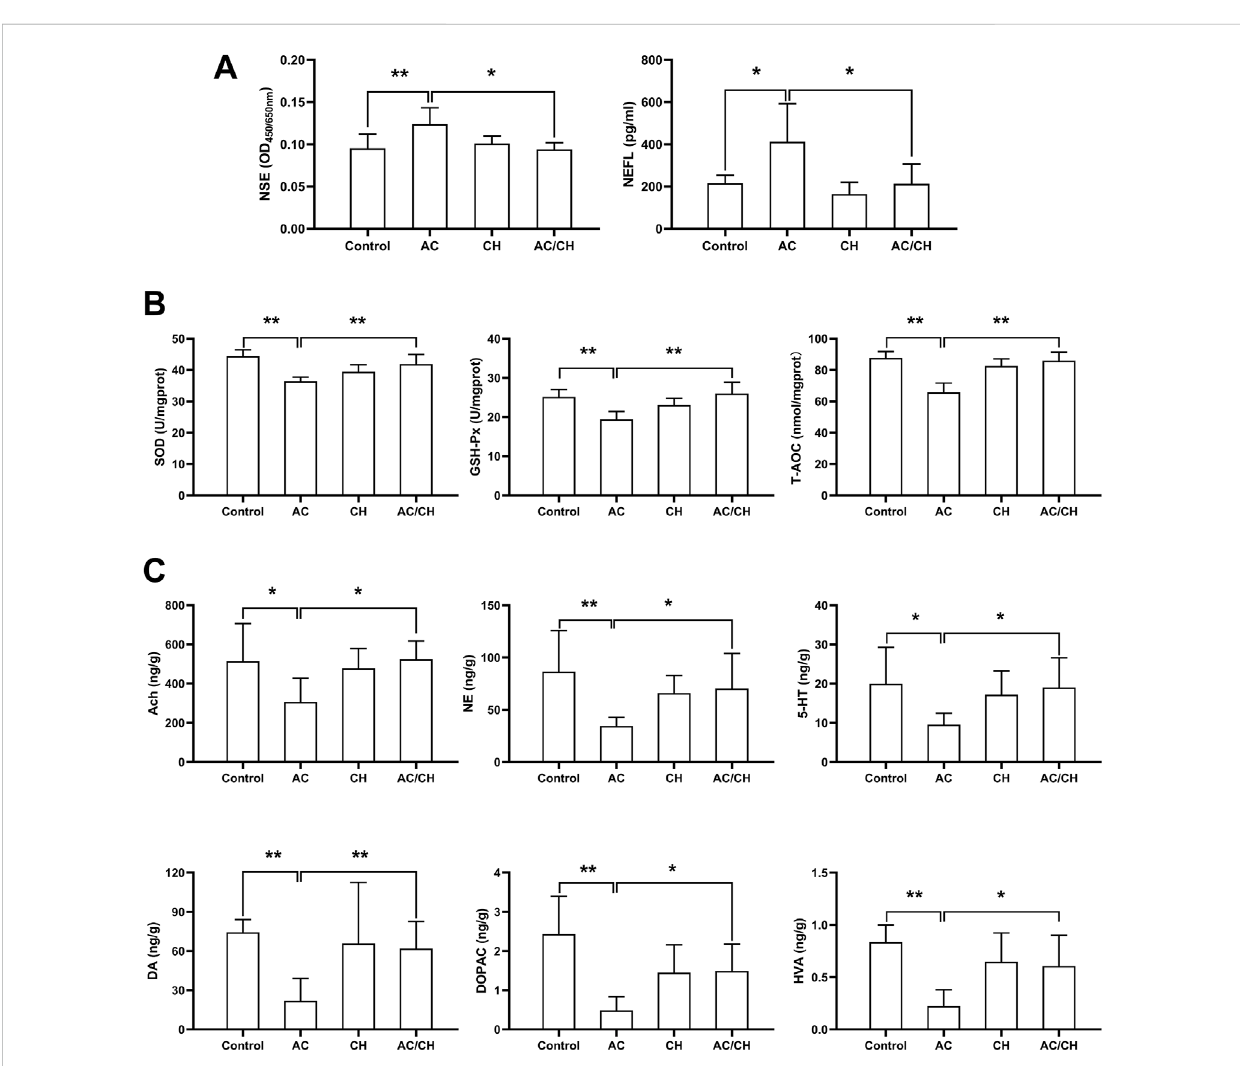
FIGURE 5 The effects of Alangium chinense combined with the compatible herbs of JGL on neurotoxicity biomarkers, oxidative stress and neurotransmitters. Rats were orally gavaged with distilled water (control group), Alangium chinense extract (AC group), extract of compatible herbs of JGL (CH group) or a combination of AC and CH (AC/CH group) once-daily for 14 days. (A) Serum NSE and NEFL levels were analyzed by ELISA assays. (B) Superoxide dismutase (SOD) activity, glutathione peroxidase (GSH-Px) activity and total antioxidant capacity (T-AOC) in brain were detected. (C) The levels of monoamineandacetylcholine neurotransmitters in brainwereanalyzed byLC-MS/MS. Quantitativedata represent themean ± SD from6 – 8 ratsin each group. * p < 0.05, ** p <